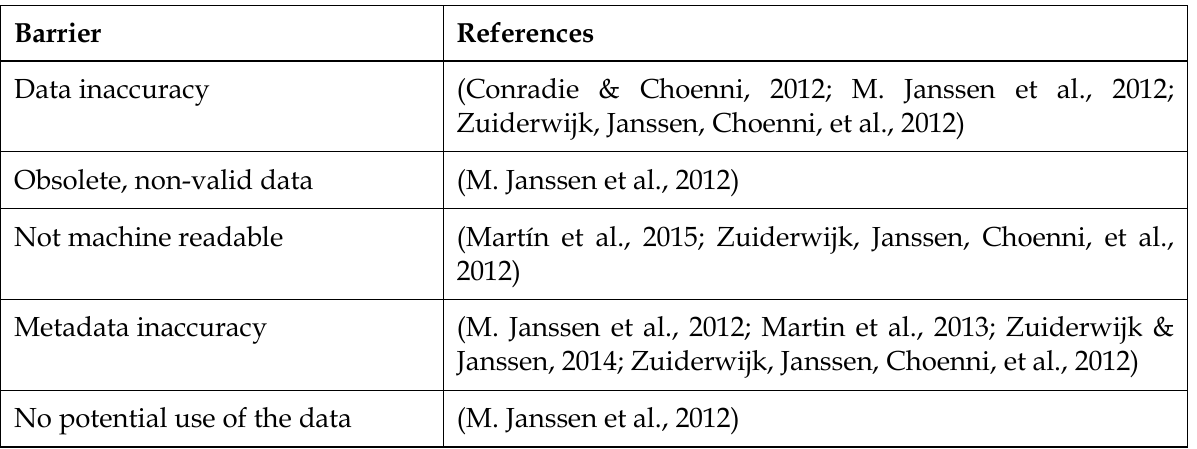
Table 2: Data Quality Barriers (Source: Authors)